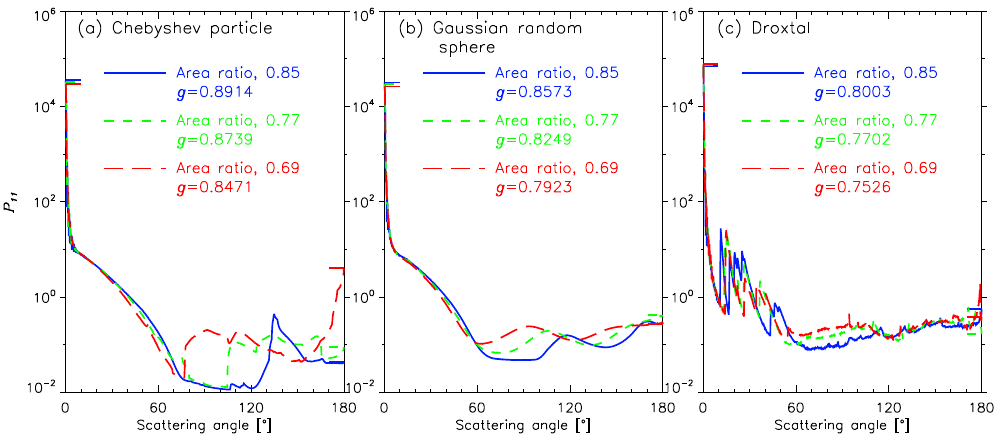
Fig. 9. Scattering phase function ( P 11 ) and asymmetry parameter ( g ) for (a) Chebyshev particles, (b) Gaussian random spheres, and (c) droxtals with varying area ratio. The direct forward and backward peaks are indicated by bars. The shapes of Chebyshev particles, Gaussian random sphere, and droxtals are shown in Figs. 4, 5, and 6, respectively.